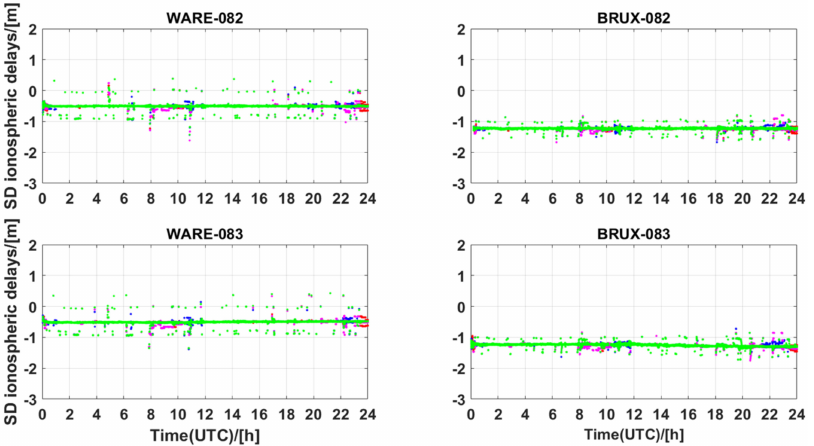
Figure 14. SD slant ionospheric delays of WARE and BRUX stations; difference between the in- terpolated slant ionospheric corrections derived from the reference network and estimated slant ionospheric delays derived from the user stations on DOY 082, 083, 2021. The four groups of UCPPP PAR solutions—F2-MAX, F2-ALT, F3-MAX, and F3-ALT—are plotted as solid red, blue, pink, and green circles,